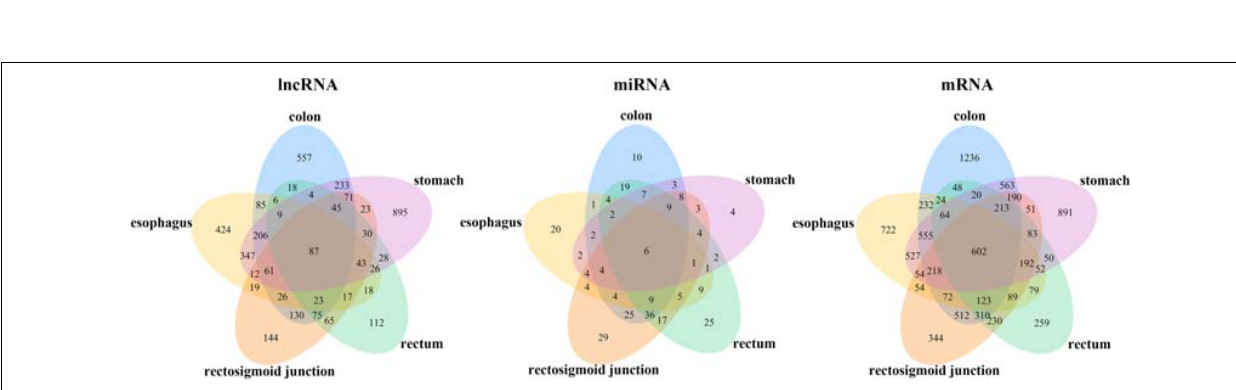
FIGURE 2 | Venn diagram of the DEmRNAs, DEmiRNAs, and DElncRNAs in five cancers. Different colors indicate the different cancers. The numbers represent the common RNAs among different cancers. The color of blue, orange, pink, green and yellow represent for colon, rectosigmoid junction, stomach, rectum, and esophagus cancer,